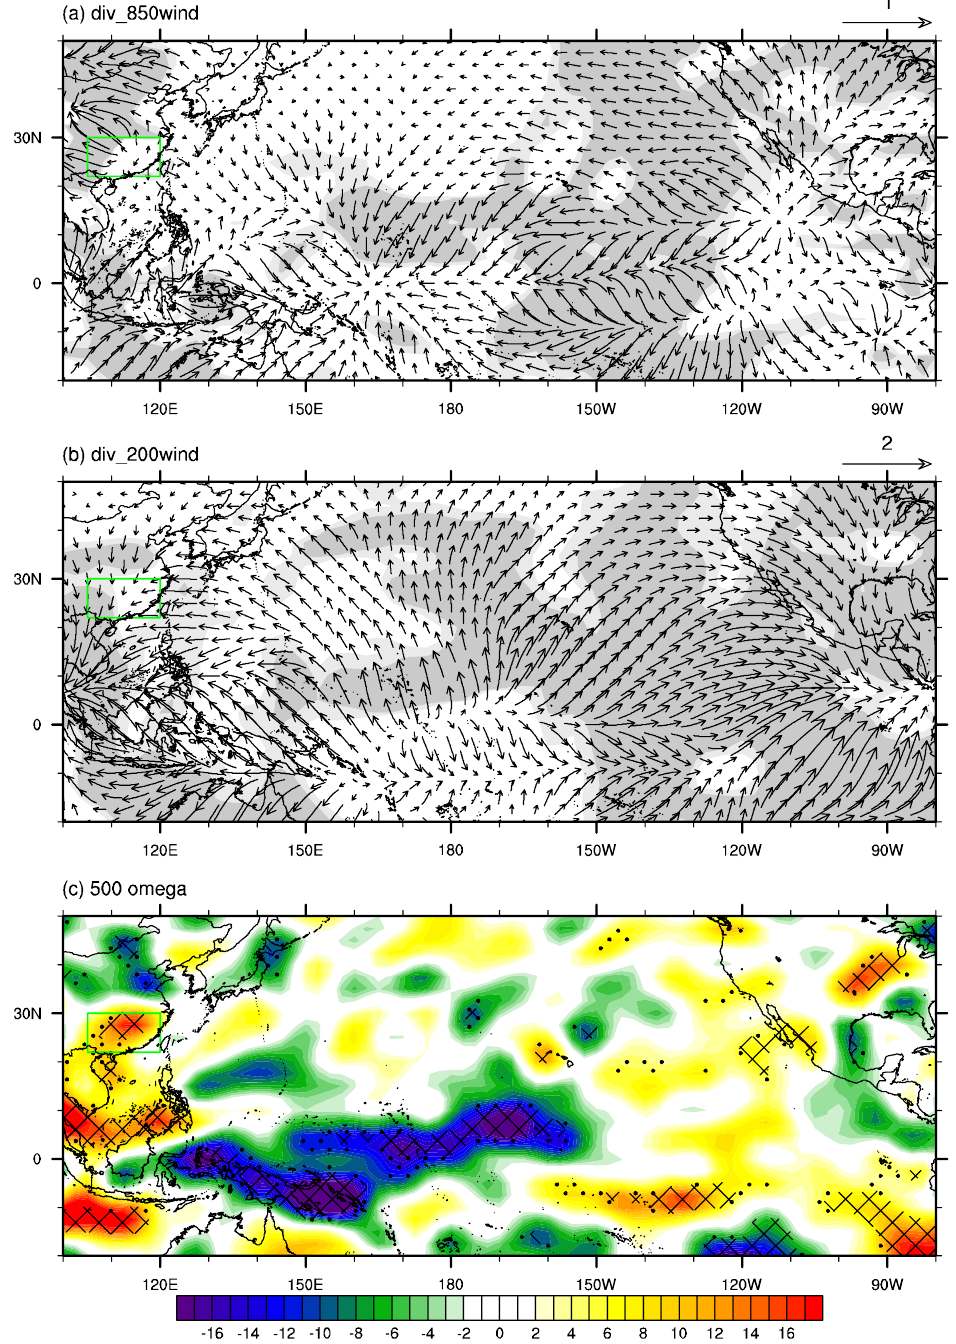
Figure 9. The differences in the summer mean ( a ) divergent components of 850 hPa wind (vector, unit: m s − 1 ), ( b ) divergent components of 200 hPa wind (vector, unit: m s − 1 ), and ( c ) 500 hPa vertical velocity (unit: 10 − 3 Pa s − 1 ) between P2 and P1 (P2 minus P1). Light (dark) shadings in ( a , b ) and dots (meshes) in ( c ) denote where the anomalies are significant at the 90% (95%) confidence level based on Student’s t -test. The green rectangle in ( a – c ) refers to the domain of southern China.